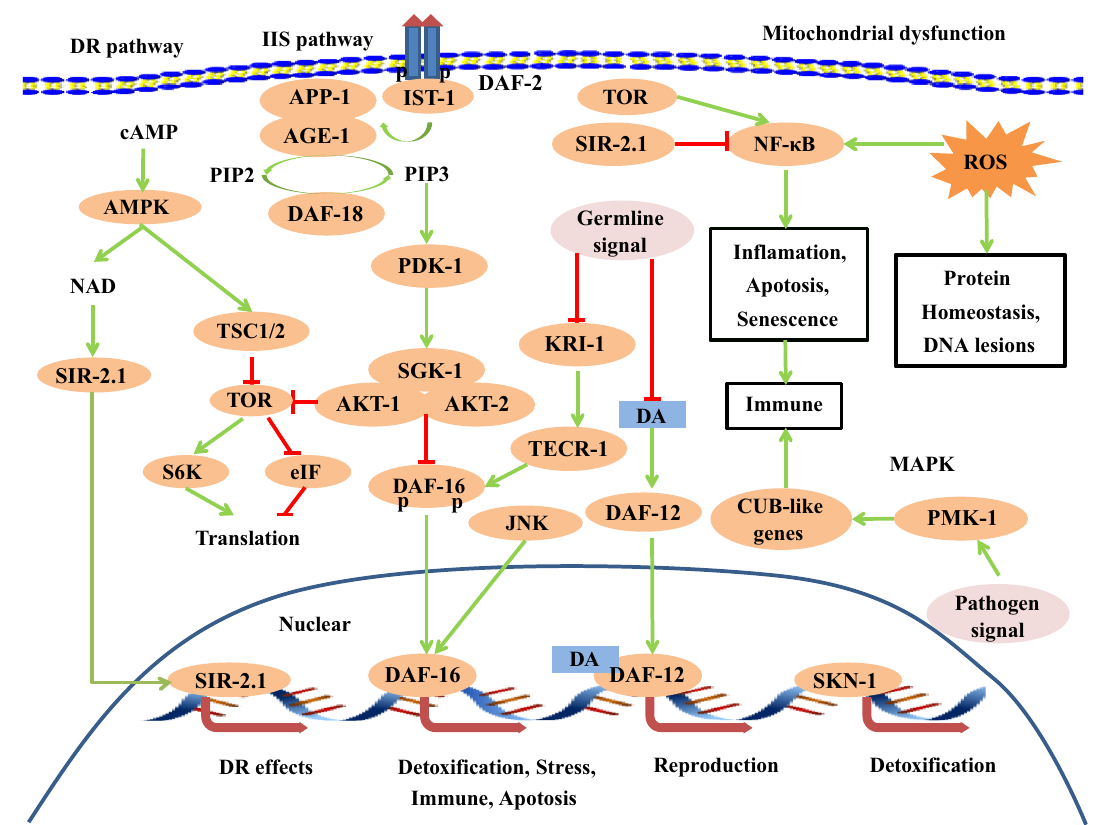
Fig. 2 Signaling networks in aging. Dietary restriction (DR), insulin/IGF-1-like signaling (IIS), germline, MAPK and mitochondrial dysfunction pathway networks in